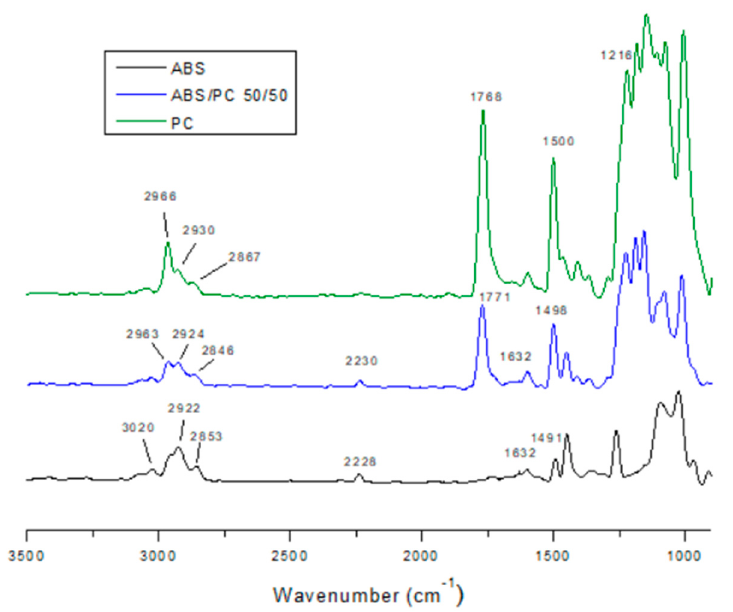
Figure 2. FTIR spectra of acrylonitrile butadiene styrene (ABS), ABS/polycarbonate (PC) 50/50 blend, and PC.